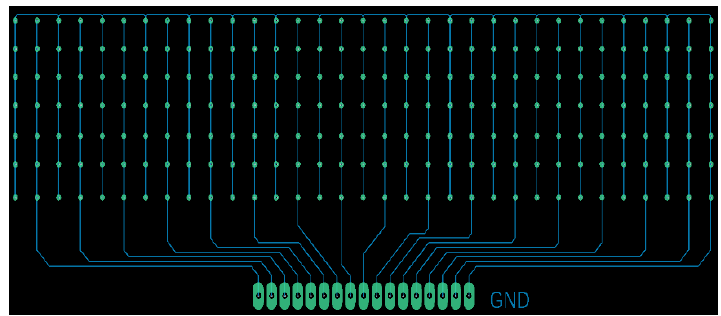
Figure 8. Scheme of a varactor DC biasing layer. The vias (shown in green) were shortened by vertical DC lines for each unit cells column on the prototype biasing layer. Thus, all odd columns were connected to a common DC ground, and each even column was connected to a separate independent DC voltage of V 1 to V 16 .